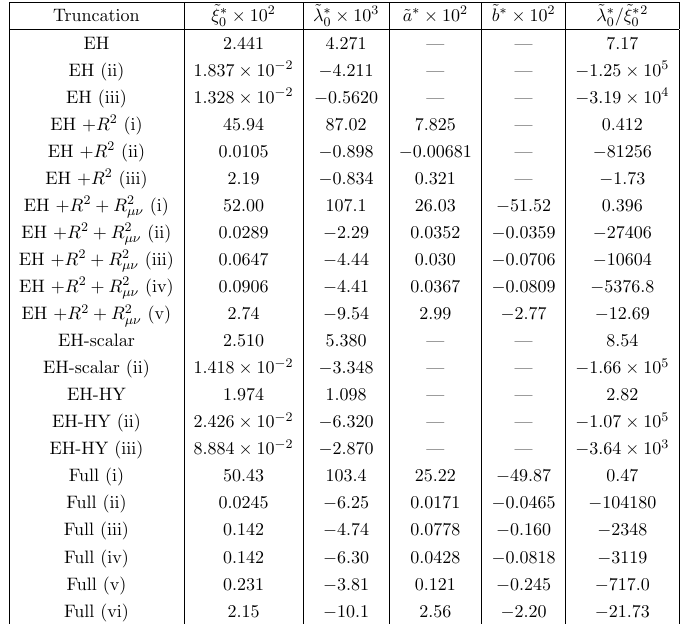
Table 9 . The values of (cid:12)xed points for (cid:11) = 0 and (cid:12) = (cid:0) 2.